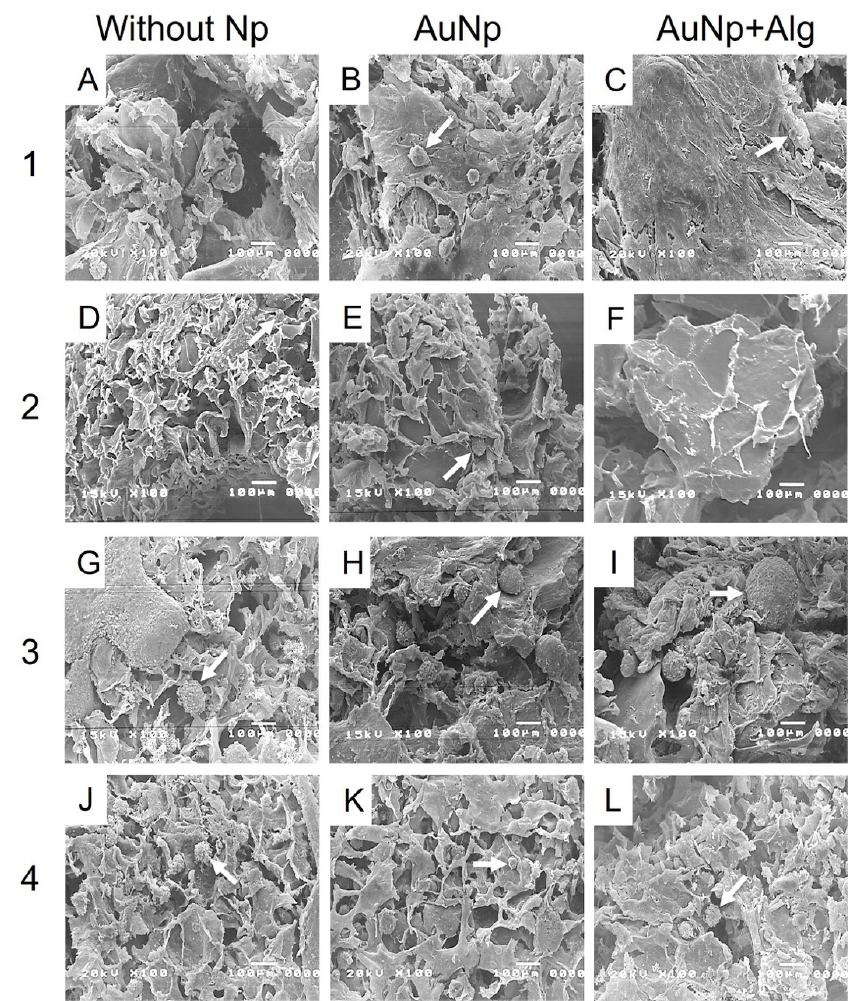
Figure 5. Representative electromicrographs of cross sections of the constructs. Method 1: ( A ) without Np, ( B ) AuNp and ( C ) AuNp+Alg. Method 2: ( D ) without Np, ( E ) AuNp and ( F ) AuNp+Alg. Method 3: ( G ) without Np, ( H ) AuNp and ( I ) AuNp+Alg. Method 4: ( J ) without Np, ( K ) AuNp and ( L ) AuNp+Alg. Identifier: arrow (spheroids).